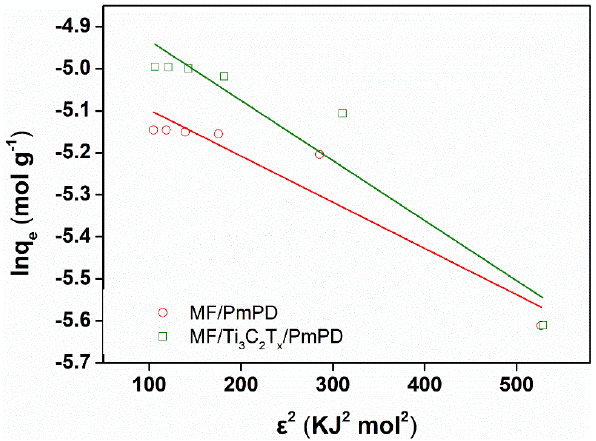
Figure 8. D–R isothermal adsorption fitting of Cr(VI) adsorption by MF/PmPD and MF/Ti 3 C 2 T x /PmPD. Table 2. Fitting parameters of D–R model of MF/PmPD and MF/Ti 3 C 2 T x /PmPD. Adsorbents q m (mg/g)